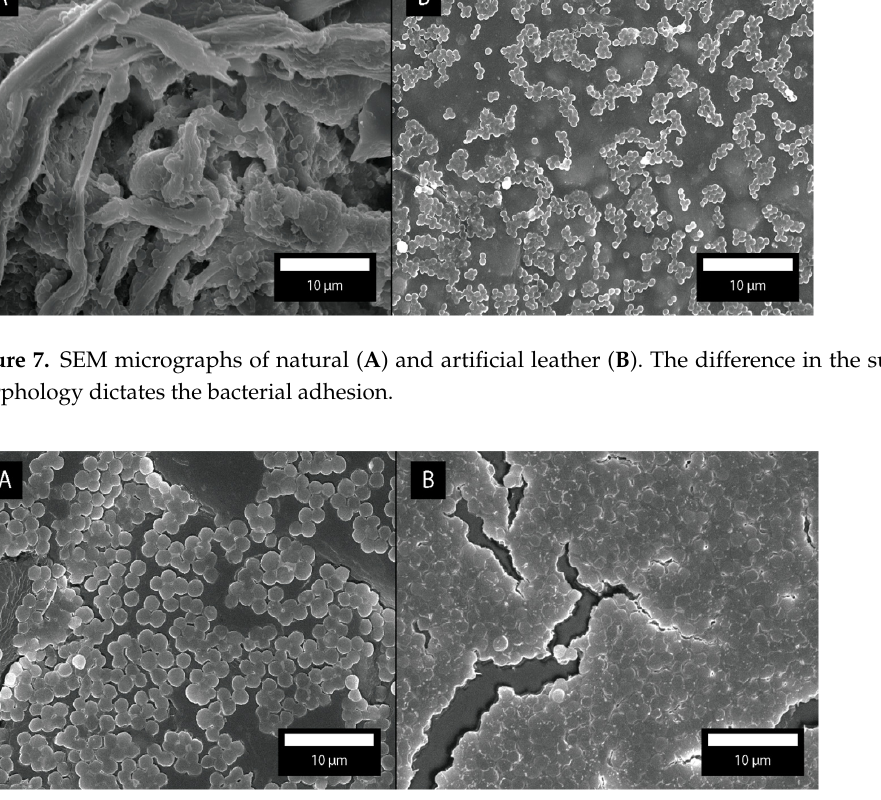
Figure 8. Closed ‐ cell PE surface ( A ) with Ag nanoparticles and ( B ) without Ag nanoparticles. Most of the surface is covered with spherical S. aureus .